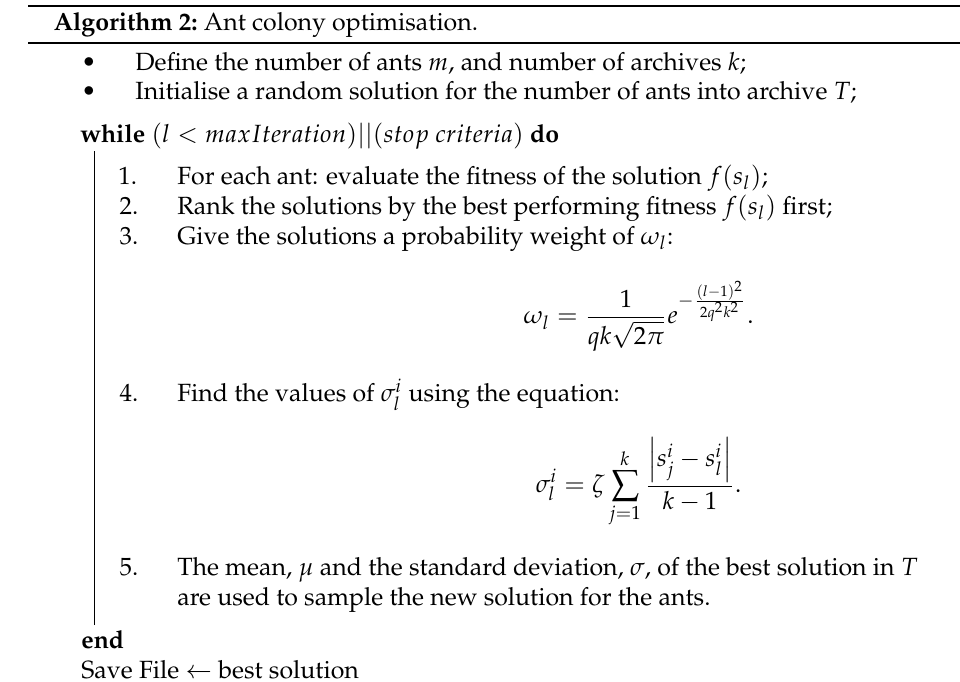
Algorithm 2: Ant colony optimisation.